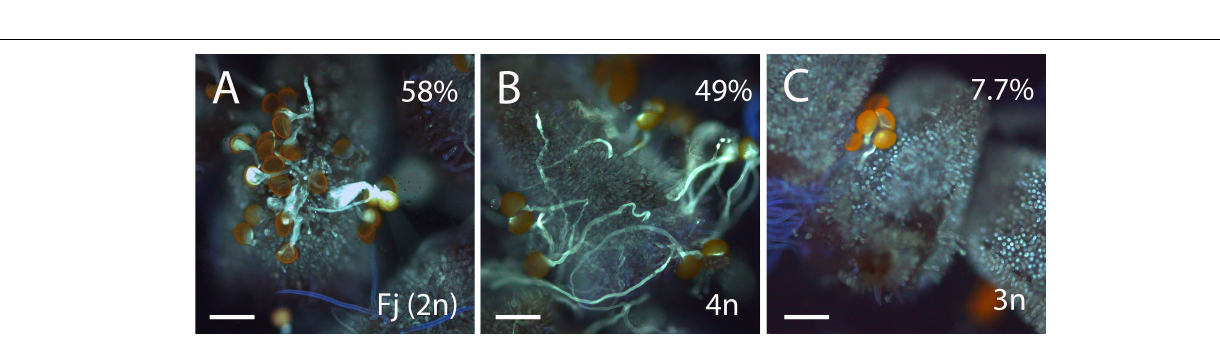
Frontiers in Plant Science |